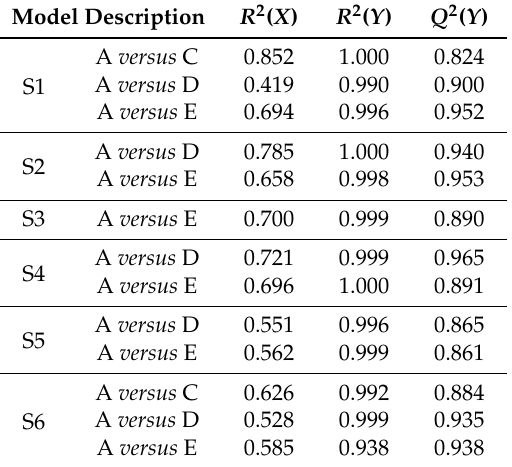
Table 1. Valid orthogonal partial least squares to latent structures discriminant analysis (OPLS-DA) models that were able to discriminate between electrical conductivity (EC)-treatments. Validation of the models was performed by CV-ANOVA ( p -value < 0.05), permutation testing and three model characteristics (( R 2 ( X ), R 2 ( Y ), and Q 2 ( Y )) (SIMCA 13, Malmö, Sweden). All of the presented models performed well for CV-ANOVA and permutation testing. The following labeling of EC-treatments